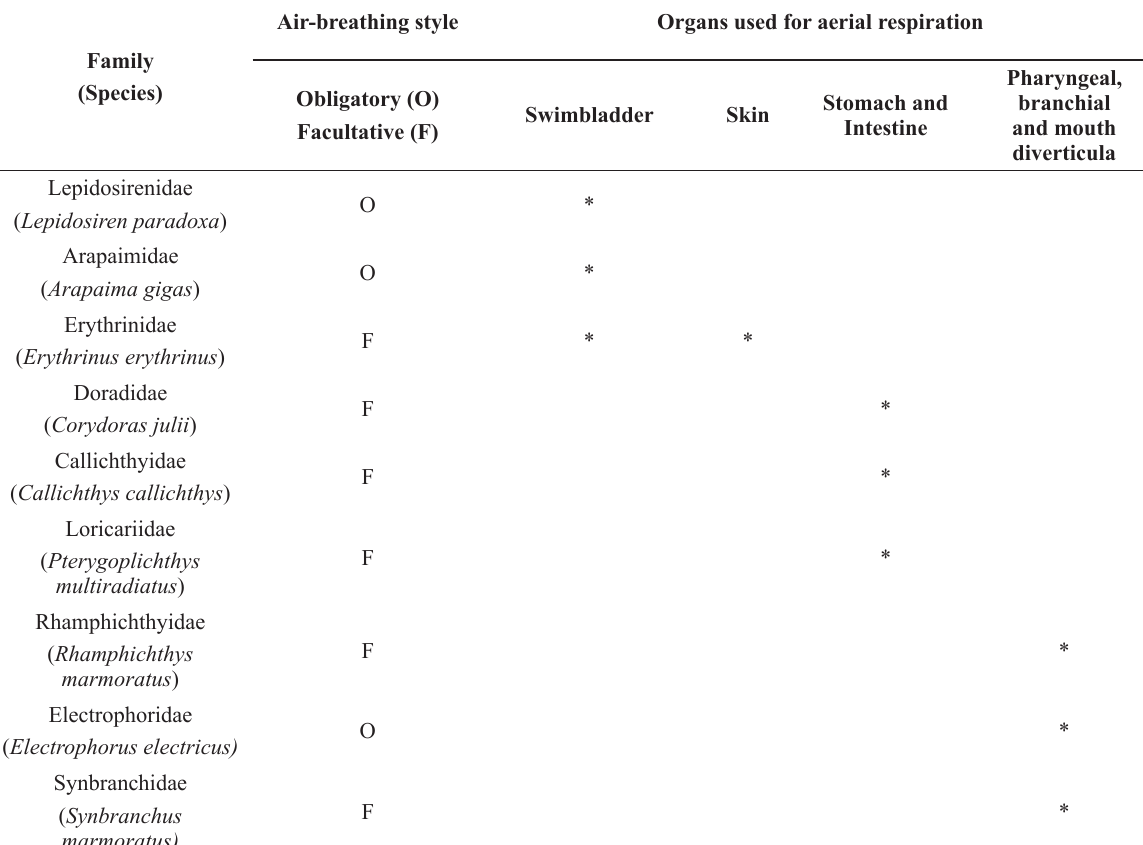
Examples of facultative and obligatory air-breathing fish of the Amazon and organs used aerial